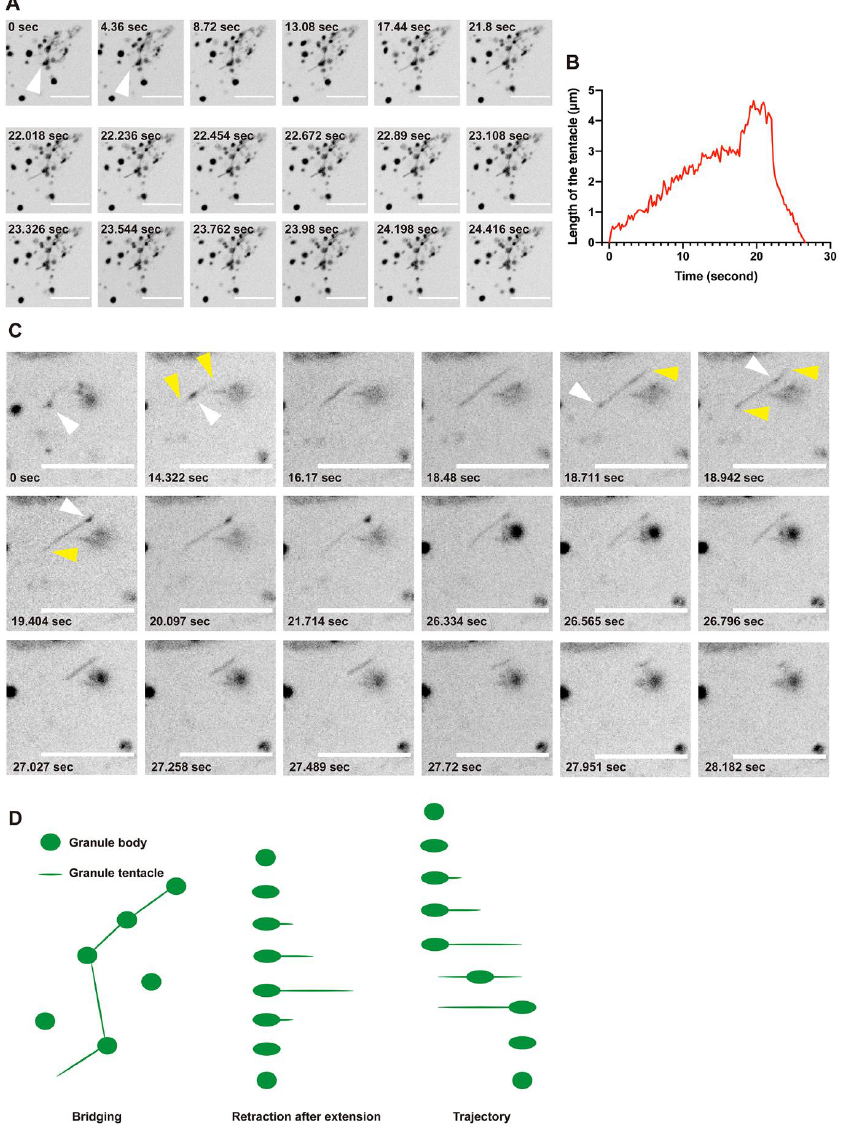
Figure 4. CTPS granules with tentacles. ( A ) Tentacles connect hCTPS1 granules. Tentacles extend and retract. Arrowheads indicate the tentacle. ( B ) Tentacles extend slowly and retract rapidly after reaching the maximum length. ( C ) hCTPS1 granules move from one side to the other along the tentacles. Yellow arrowheads indicate the tentacles; white arrowheads indicate the granules. ( D ) hCTPS1 granular tentacles have three different behaviors and characteristics, bridging, retraction after extension and the trajectory of hCTPS1 granule movement. For the DON treatment, DON (PBS solution) was added to fresh DMEM medium 8 to 25 h before live-cell imaging. Scale bars, 10 µ m ( A , C